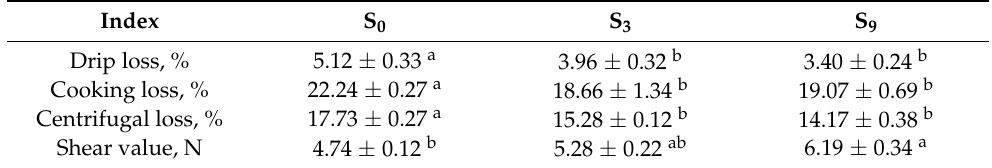
Table 1. Effects of salinity on water loss and shear value of muscle in M. salmoides (means ± S.D., n = 3).